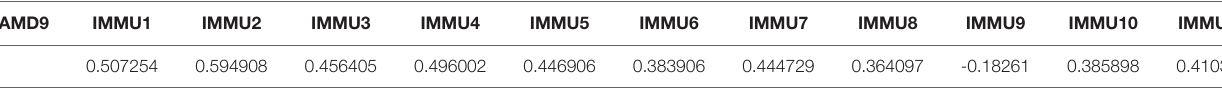
TABLE 4 | SAMD9 and related immune scores in TCGA database